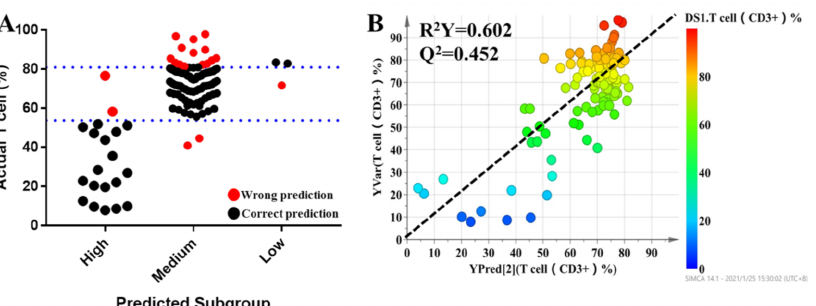
Figure 5. The results of multinomial logistic regression ( A ). Each dot represents an individual. The black dots indicate individuals who could be correctly predicted, while red dots mean individuals who were inaccurately predicted. Refined PLS predicted modeling to predict the percentage of T lymphocytes of tacrolimus ( B ).